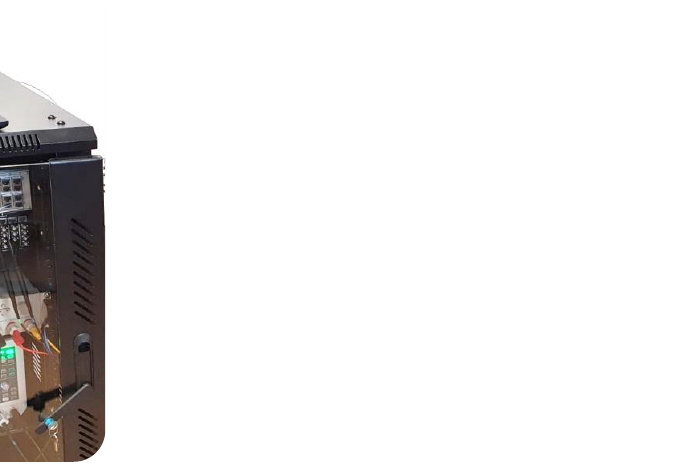
. The switches’ current waveforms are shown in Figure 9c,d, while their maximum values are 13 A according to (25) to (28). The output voltage is almost equal to 209 V , reconfirming the theoretical calculation (see Figure 9e).